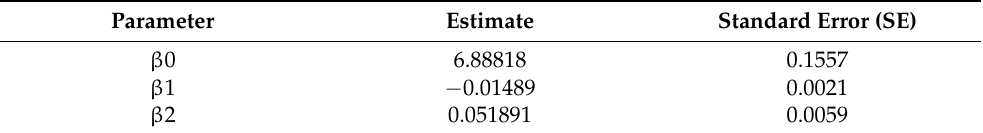
Table 4. ML parameter estimation